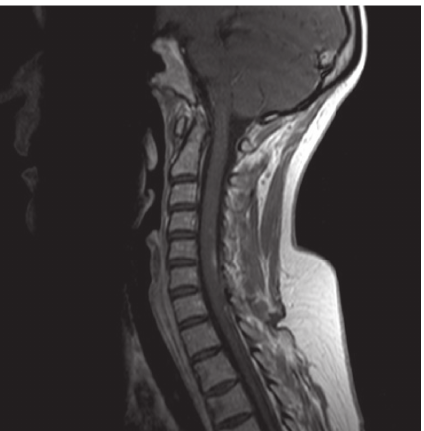
Figure 1: MRI spine showed a long intramedullary inflammatory lesion in thecord fromC3 to theupper boarder of T1 on T1-weighted MRI